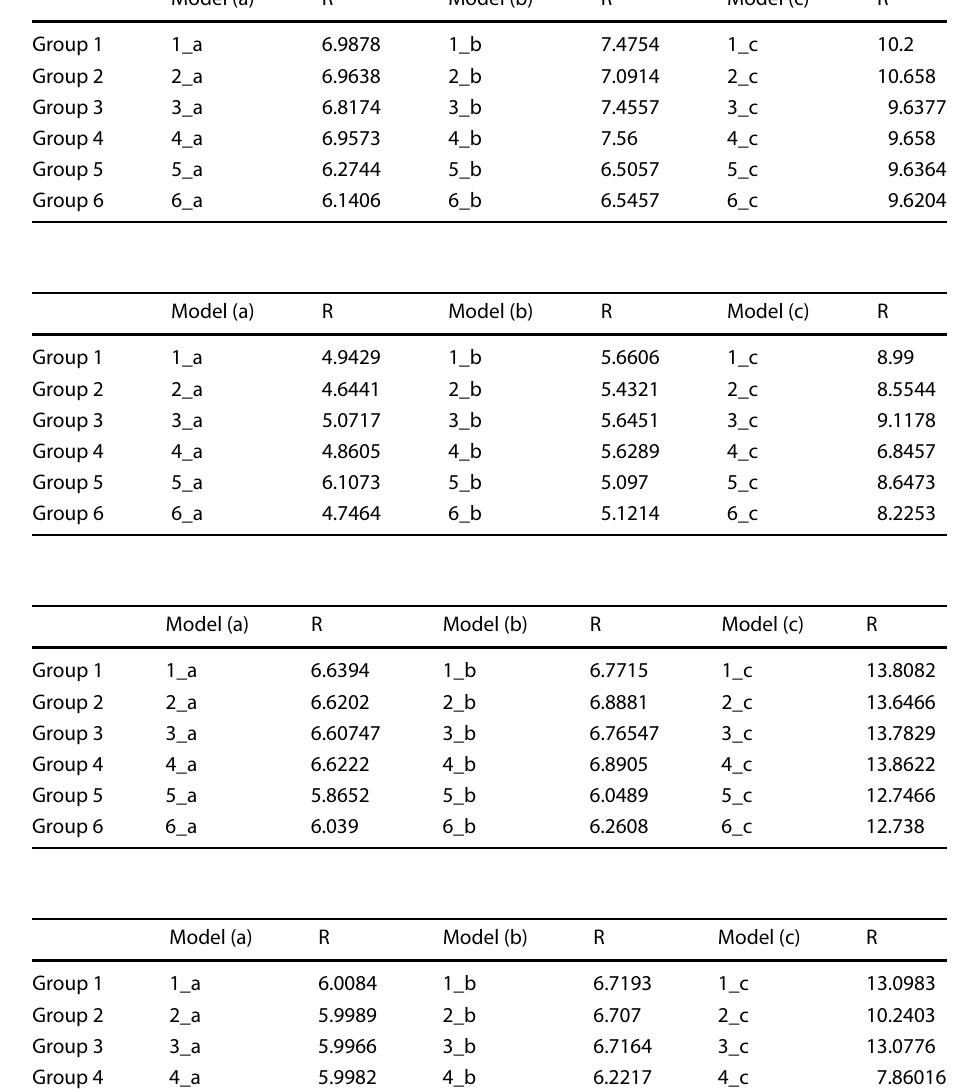
Table 4 The response modification factors of 4-story 2-span structure